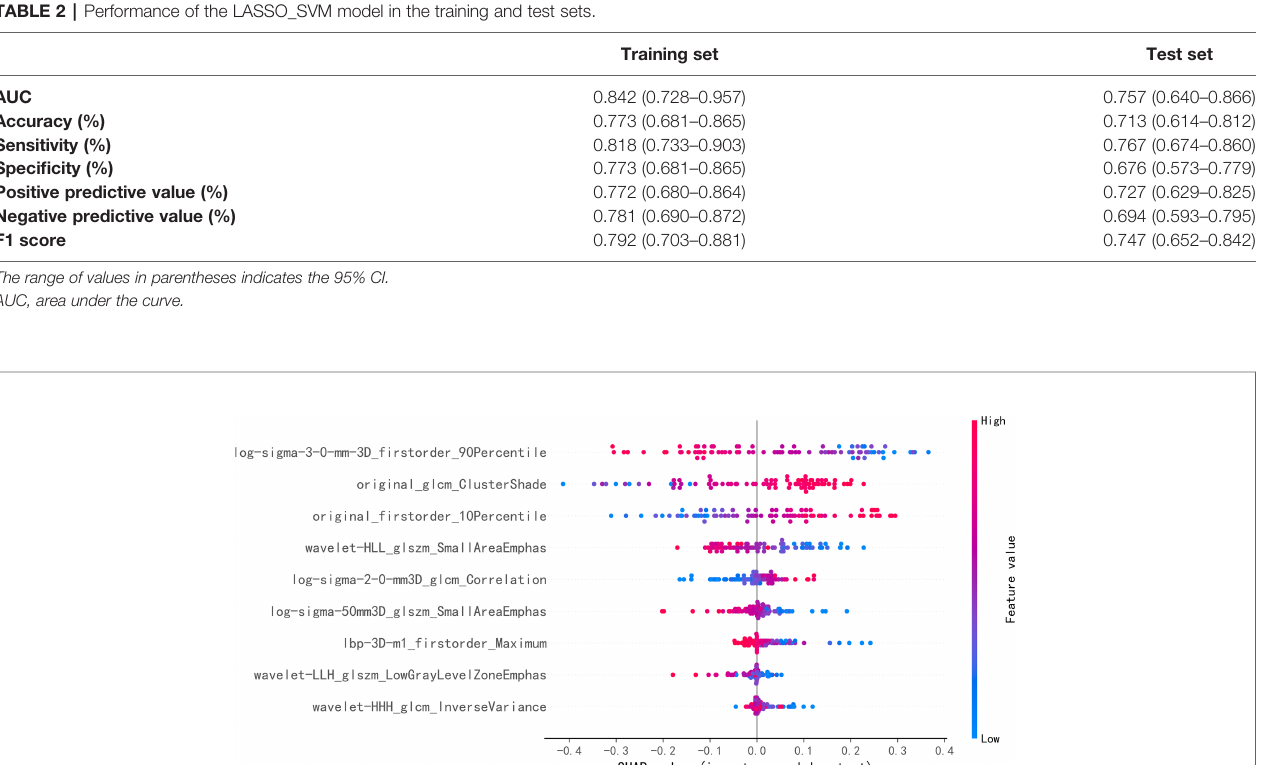
TABLE 2 | Performance of the LASSO_SVM model in the training and test sets.